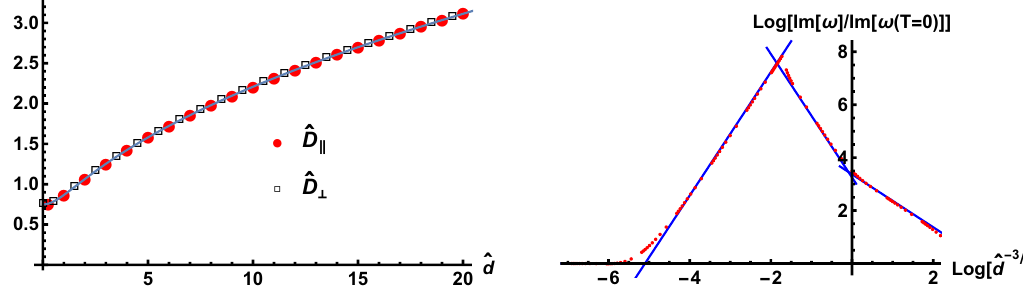
Figure 4 . On the left panel we compare the numerical results for the reduced in-plane and o(cid:11)- plane di(cid:11)usion constants ^ D and ^ D ? (discrete points) and the analytic results (4.82) and (4.96) k (continuous curve). On the right panel, we plot the imaginary part of the lowest in-plane excitation mode, keeping ^ k = ^ d 3 = 8 = 0 : 01, so that both the density and the wavevector are kept (cid:12)xed and only k the temperature varies. The red points are numerical results and the line segments have slopes 0, 7 = 3, -7 = 3, -1 from left to right. The latter two slopes correspond to the low and high temperature behavior of the di(cid:11)usion constant (see (4.87) and